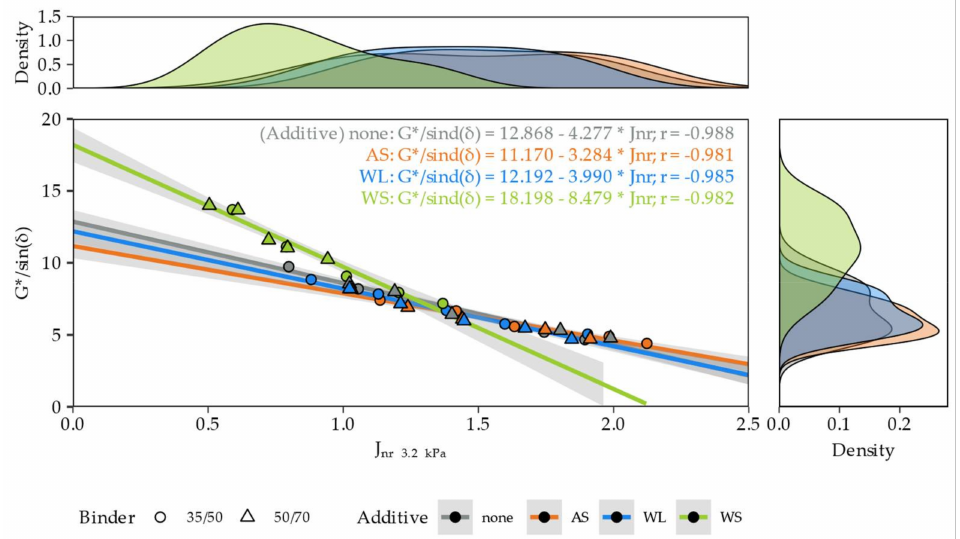
Figure 11. Correlations between the high-temperature stiffness (G*/sin( δ )) and non-recoverable creep compliance (J nr 3.2 kPa ) measured at 64 ◦ C for the 35/50 bitumen-based binders and at 58 ◦ C for the 50/70 bitumen-based